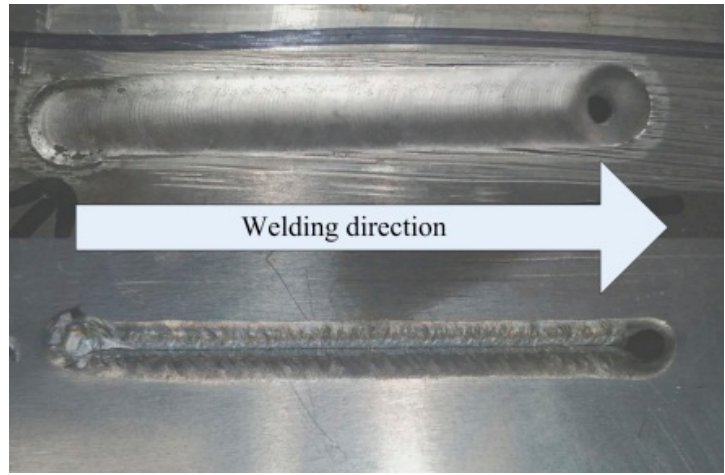
Figure 10. The front and back of the PPG-VPPA (20 Hz) weld joint.